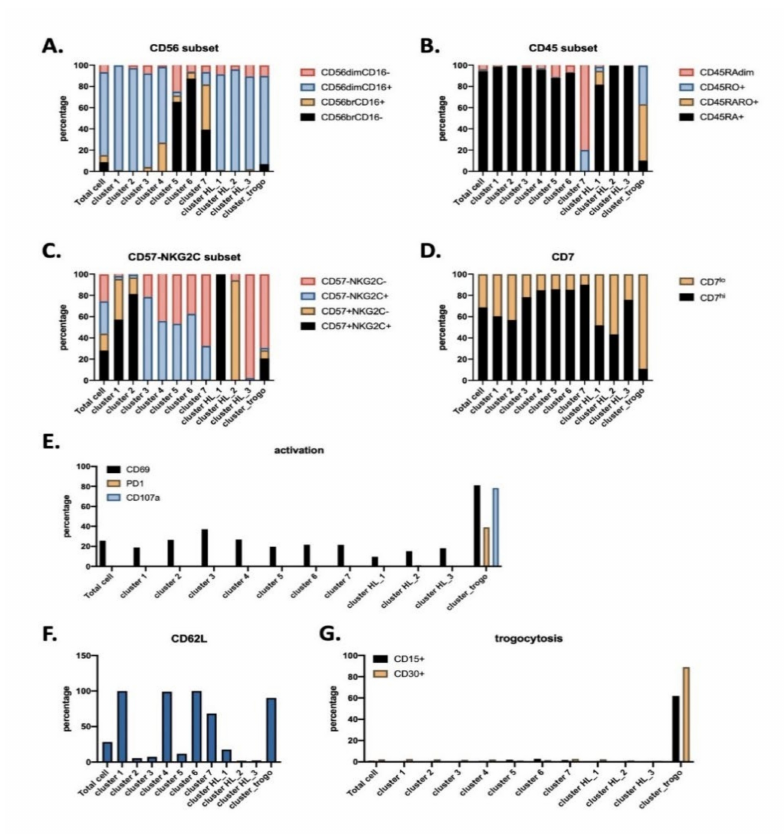
Figure 4. Phenotype of NK cell clusters identified via UMAP. Graphs represent for each individual cluster the percentage of the di ff erent NK cell subset. A–G ) characterization of NK phenotype regarding to: CD56 subsets ( A ), CD45 subsets ( B ), CD57 vs. NKG2C ( C ), CD7hi (immature) vs. CD7lo (mature) ( D ), activation markers (i.e, CD69, PD1, CD107a ex vivo) ( E ), CD62L ( F ), and trogocytosis markers ( G